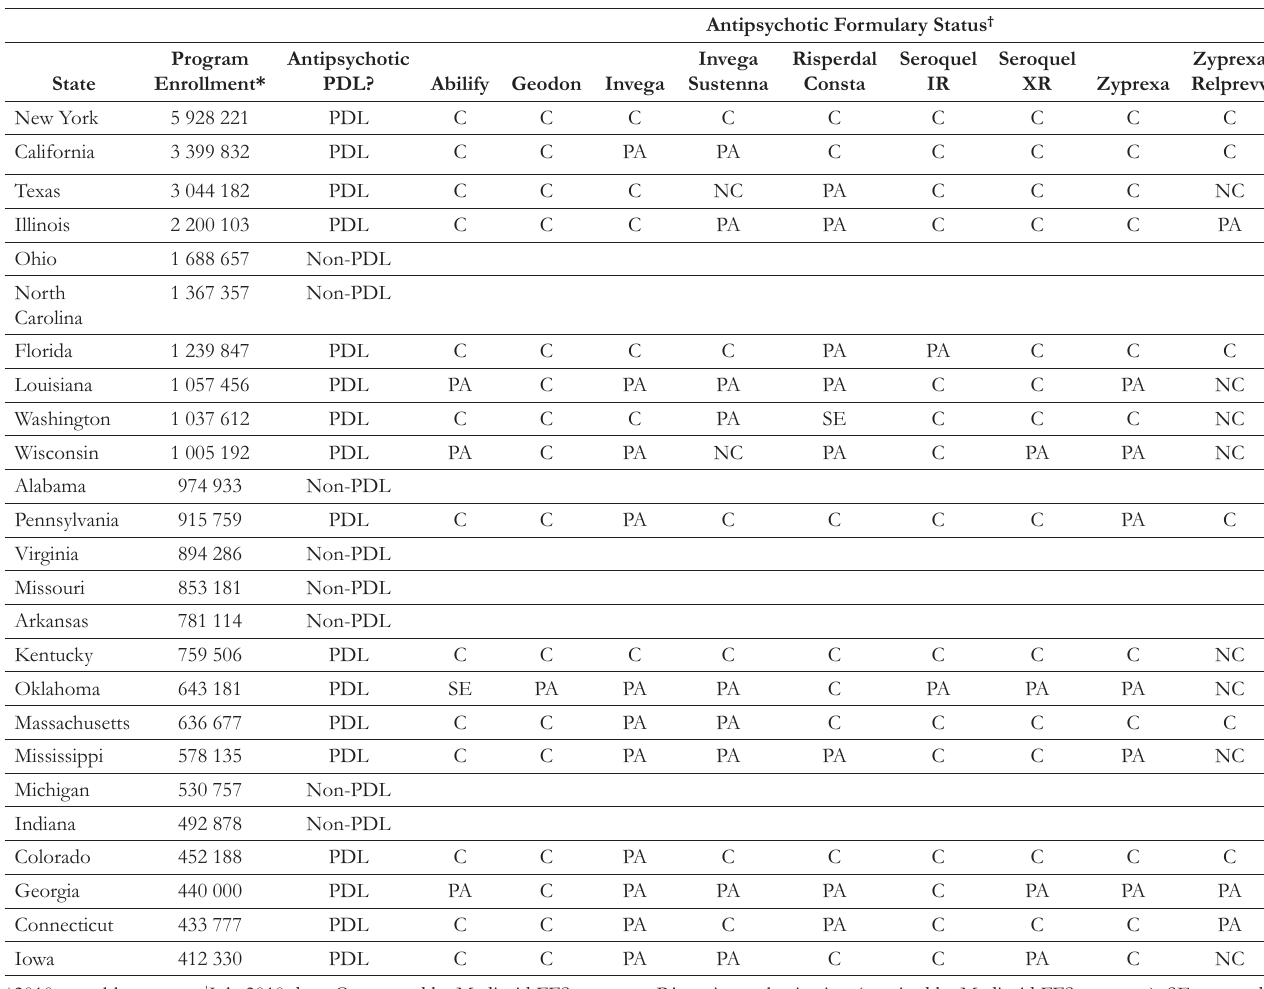
Table 3. Medicaid Fee-for-Service Antipsychotic Formulary Management Approach (2010 - Top 25 U.S. states by